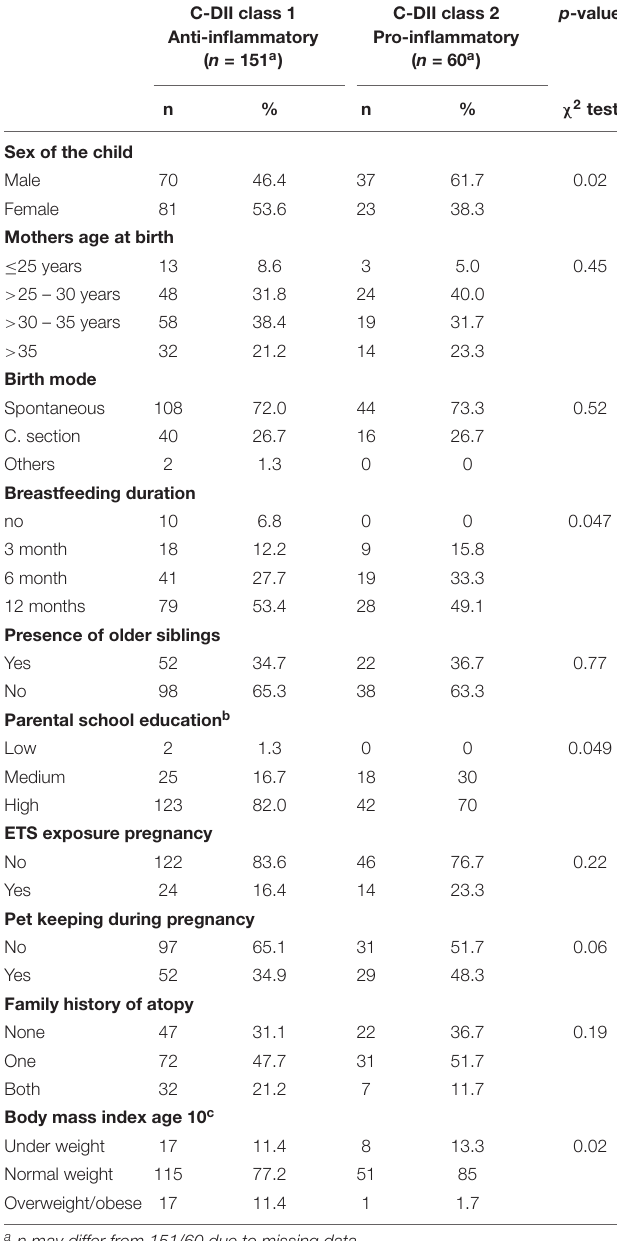
TABLE 3 | C-DII and study